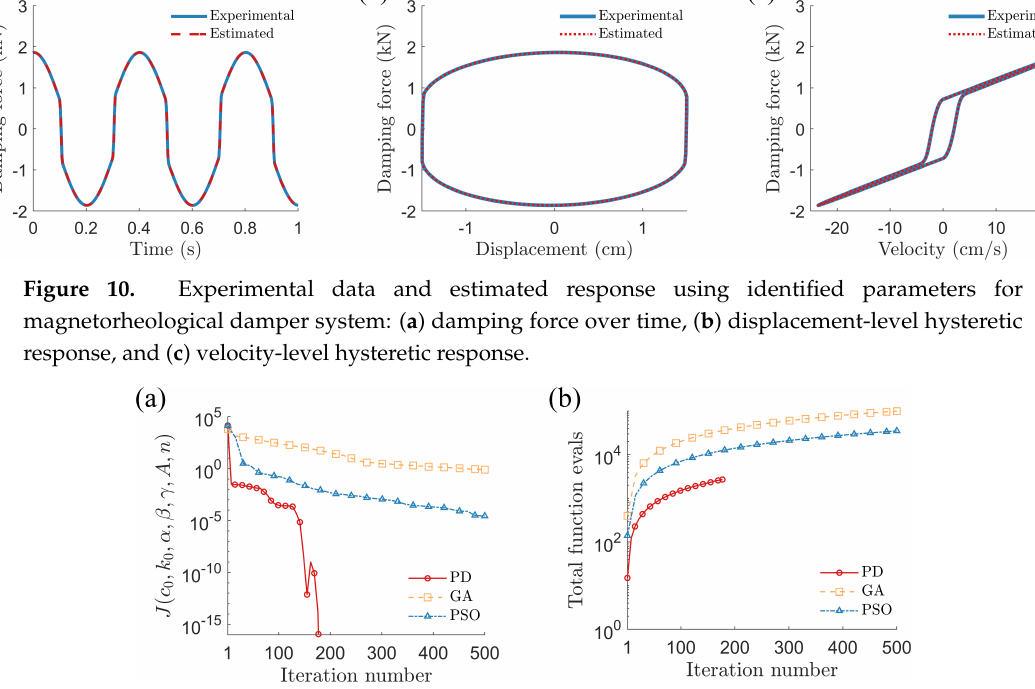
Figure 11. Performance of three strategies to identify parameters for magnetorheological damper system: ( a ) error convergence of objective function J ( c 0 , k 0 , α , β , γ , A , n ) ; ( b ) computational effort required (cumulative number of function